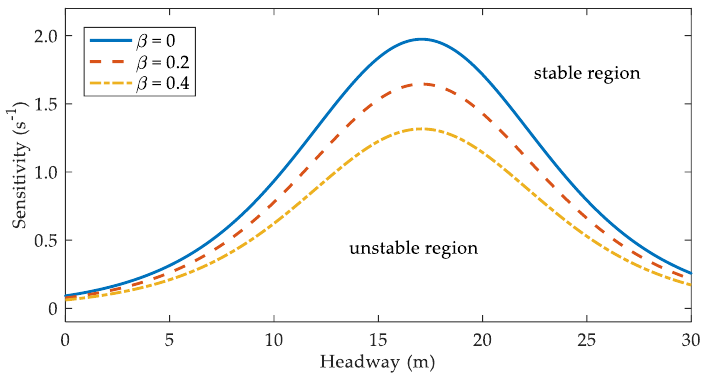
Figure 1. The neutral stability curves under different β .